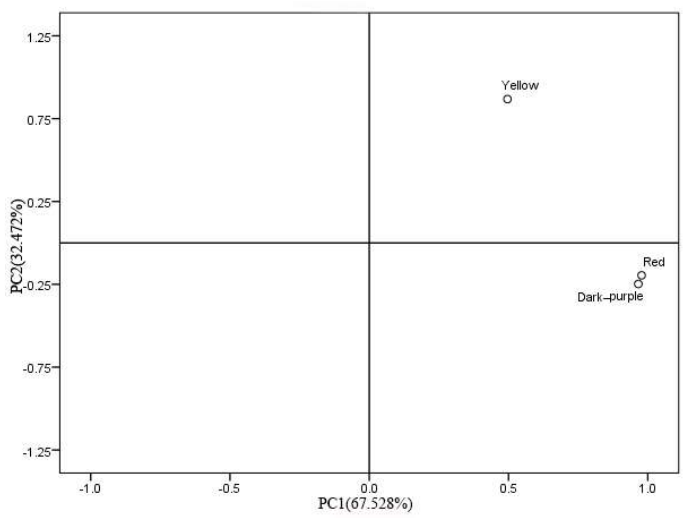
Figure 2. Sample score chart .